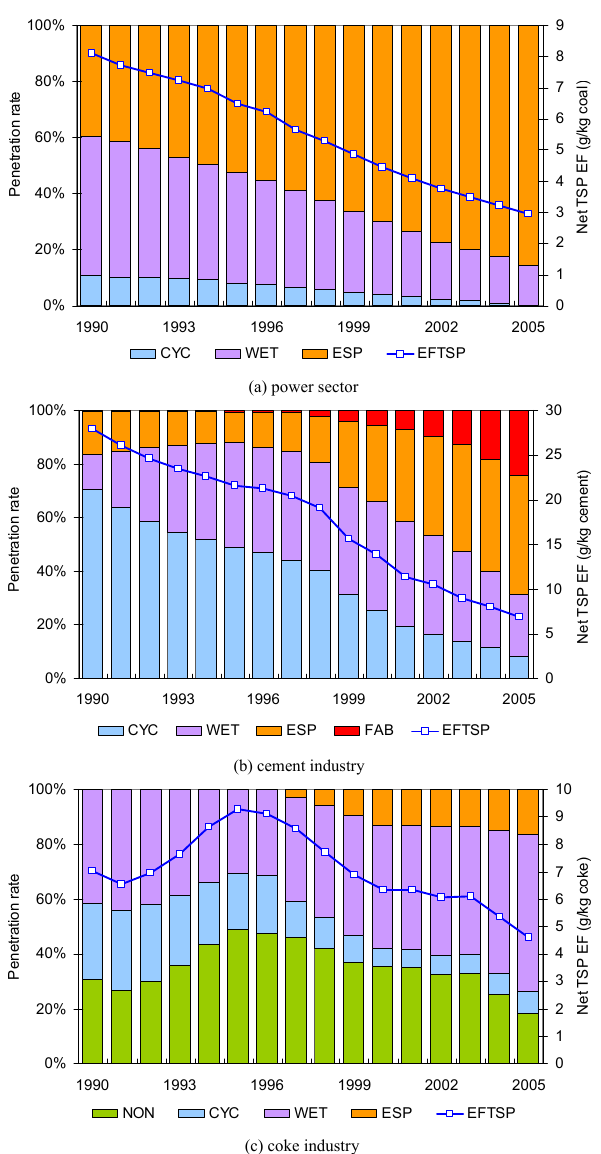
Fig. 1. As high efficient PM control technologies were gradually promoted during 1990–2005, EFs of TSP from (a) power sector, (b) cement industry, and (c) coke industry decreased. Bars rep- resent the penetration rate of PM control technologies within the industries, and line represents the net emission factor of TSP.